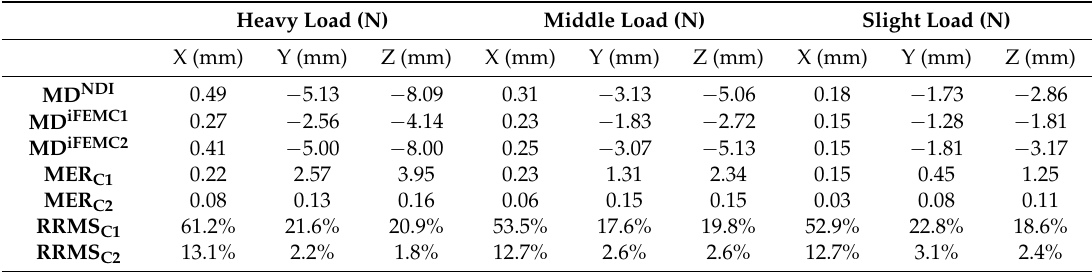
Table 7. Comparison between NDI and iFEM in the loading case of the end node.